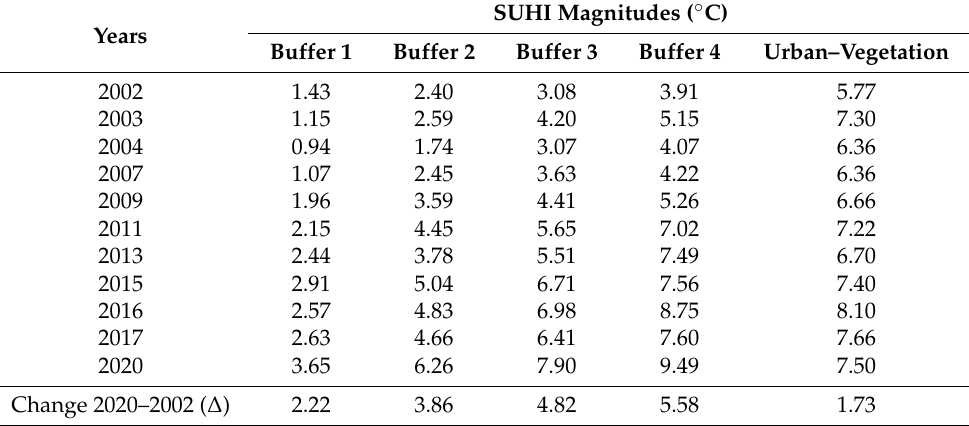
Table 5. SUHI magnitude values.